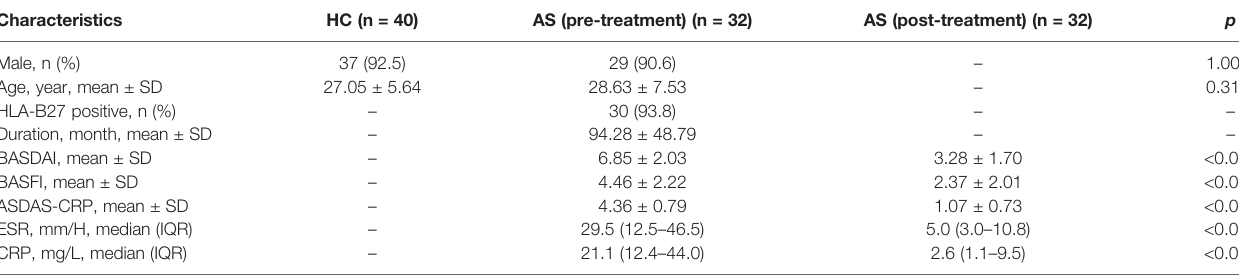
TABLE 1 | The demographic characteristics of the study